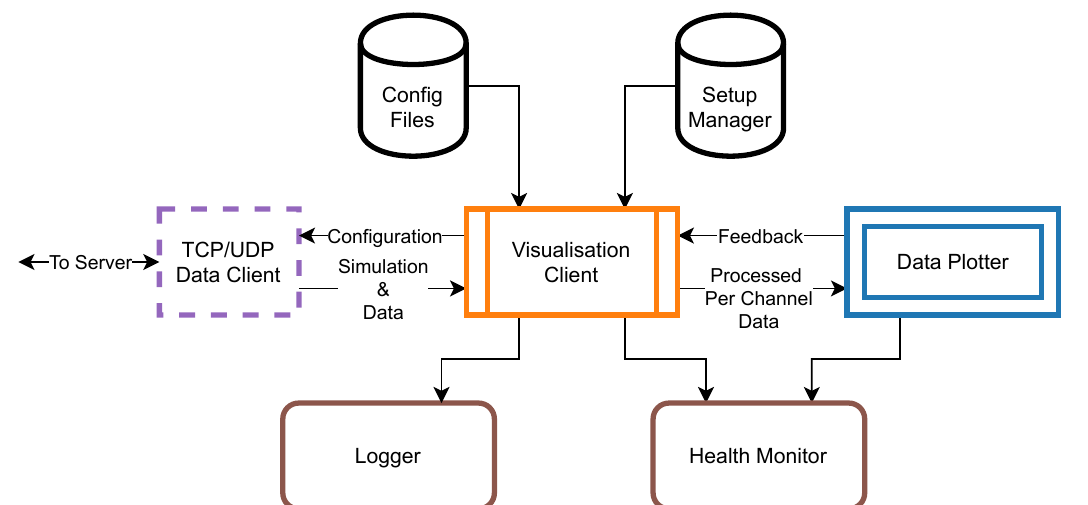
Figure 10. Visualisation Client organisation. When the Server Application is running, data can be collected by TCP/UDP Data Client then processed and plotted in accordance with the current visualisation configuration.